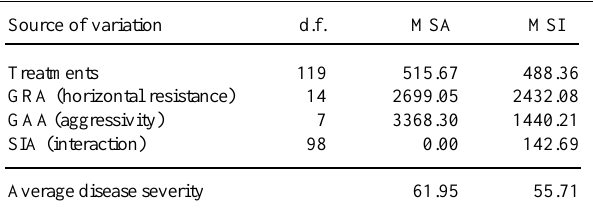
Table VII - Diallelic analysis of disease severity (without adjustment) showing mean square according to additive model (MSA) and interactive model (MSI) including 15 hosts and 8 races.